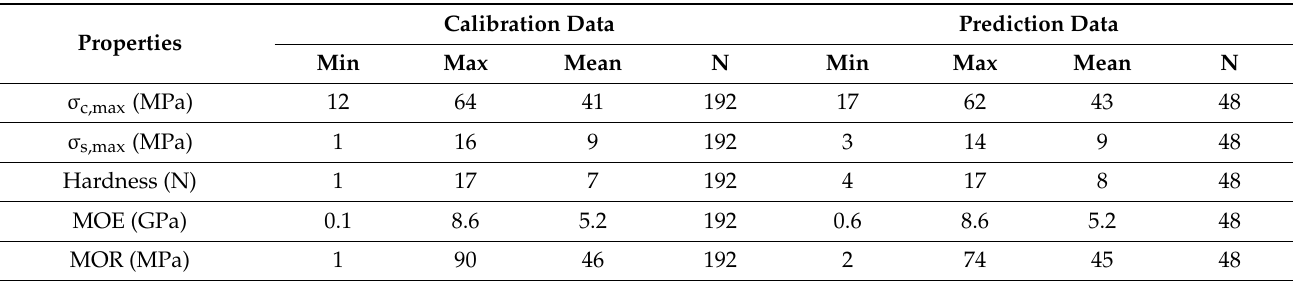
Table 2. Ranges of mechanical properties of the calibration and prediction sets in the NIR analysis